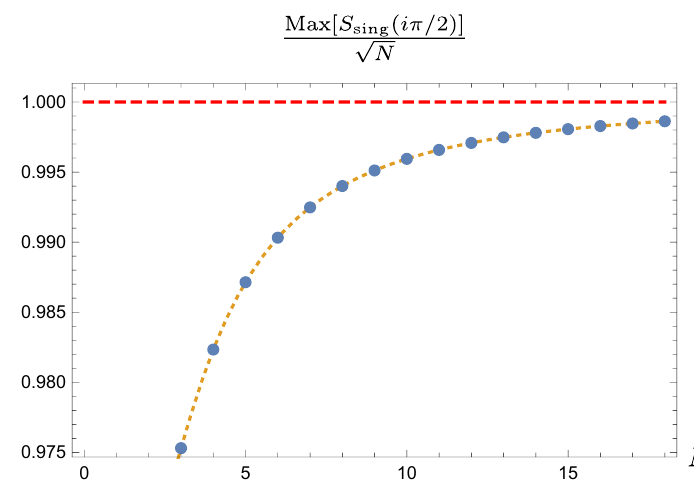
Figure 11 . Numerical results of the maximization procedure described in section 2.3 for the maximal value of the singlet S-matrix at the middle of the physical strip for various values of N . p We expect the result to approach N as N ! 1 as illustrated by the red dashed line. The yellow dotted line which perfectly passes by the numerical blue dots is the result of a more re(cid:12)ned (cid:12)nite N analytic analysis which we will consider in section